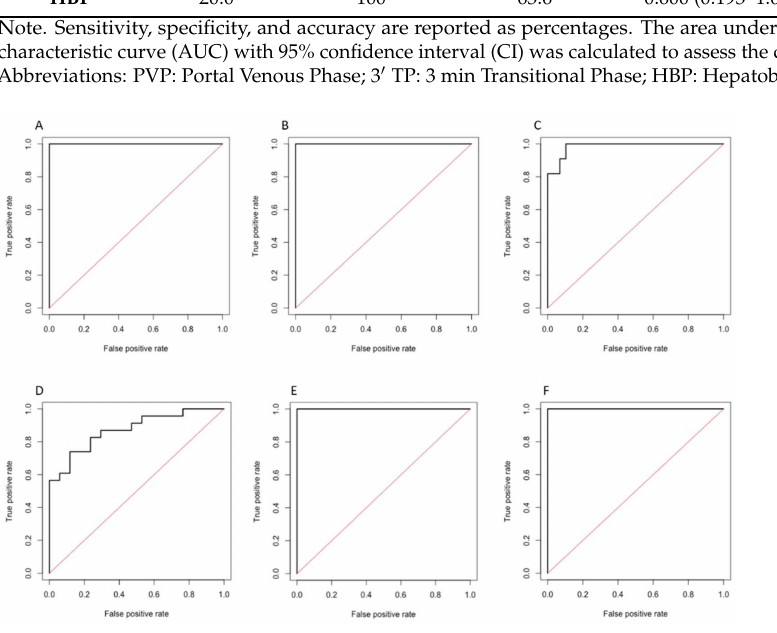
Figure 3. ROC curves of the radiomics model 1 in the training set for predicting complete response on portal-venous ( A ), 3 (cid:48) transitional ( B ), and hepatobiliary ( C ) phases, and for predicting objective response on portal-venous ( D ), 3 (cid:48) transitional ( E ), and hepatobiliary ( F )